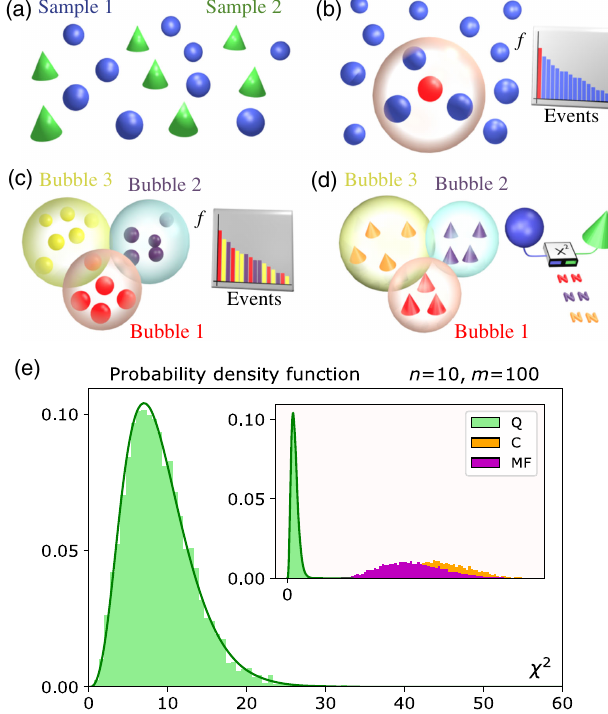
FIG. 2. Pattern-recognition techniques for validation. (a) A sample is drawn from each of the two boson samplers to be compared. The events belonging to one of the two samples are partitioned according to the criteria of the pattern-recognition technique. (b),(c) Bubble clustering sorts the events according to their observation frequency, and the state with the highest frequency is chosen as the center of the first cluster: All events with a distance from the center smaller than a cutoff radius ρ 1 are included in this cluster (b). Then, starting from the unassigned events, this procedure is iterated until all of the observed events are included in some bubble. At this point, each cluster is characterized by a center and a radius (c). (d) The observed events belonging to the second sample are classified by using the structure tailored from the first sample: Each event belongs to the − 1 cluster with the nearest center. (e) A χ 2 test with ν ¼ N bubbles d.o.f. is performed (here using K means) to compare the number of events belonging to each of the two samples [green, quantum (Q) with indistinguishable photons; orange, classical (C) with distinguishable photons; purple, mean-field state] by using the obtained cluster structure. This variable quantifies the compat- ibility between the